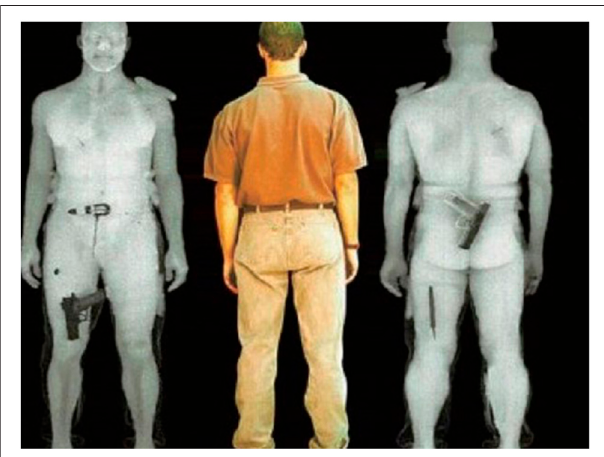
FIGURE 7 | L3 security and detection systems [32].